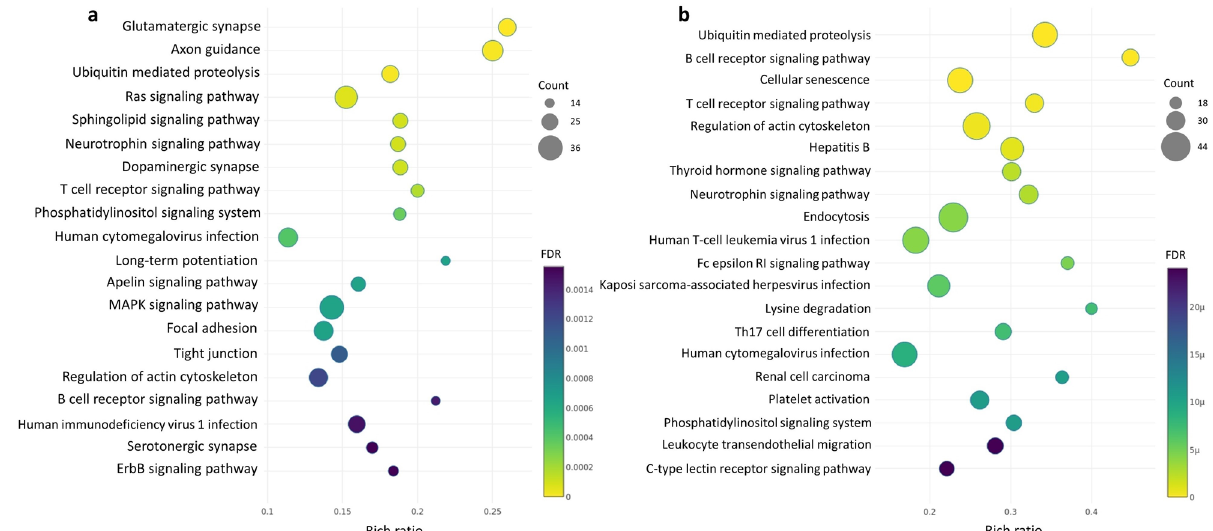
Figure 6. The 20 most enriched KEGG pathways by g:Profiler. The bubble plots show in the Y-axis the enriched KEGG pathways, while in the X-axis the rich ratio is represented (rich ratio = amount of differentially expressed genes in the term/all genes included in the term). Size and colour of the bubble represent the number of differentially expressed genes in the KEGG pathway and enrichment significance (FDR), respectively. ( a ) Encephalon; ( b )